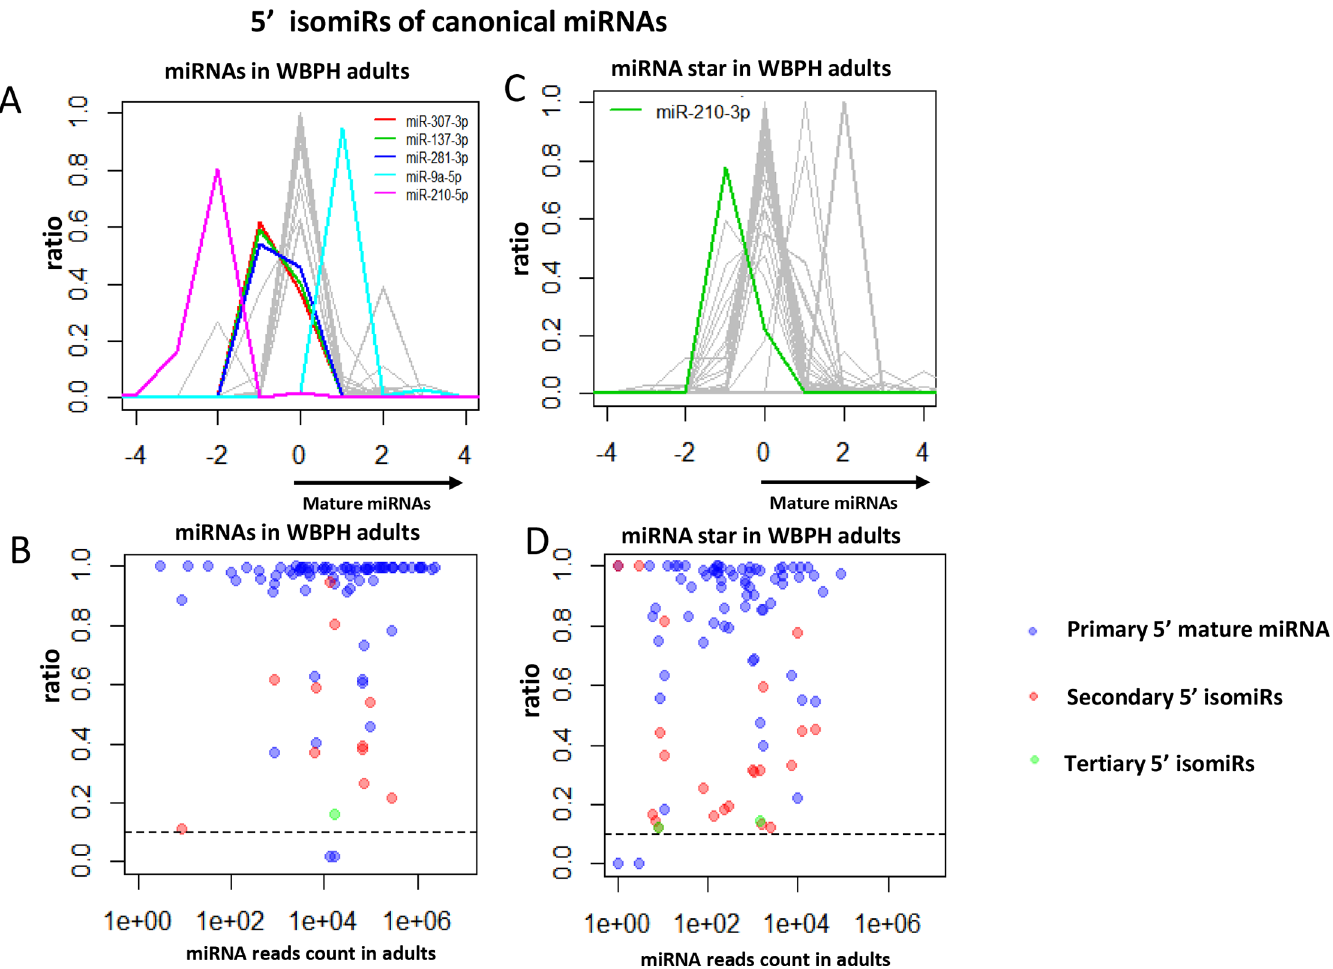
Fig 3. 5’ variability of 76 conserved WBPH miRNAs. (A, B) 5’ end precision of mature miRNAs was higher than that of miRNA star species; (C, D) 5’ end precision of miRNA species in miRNA star was generally high for well-expressed